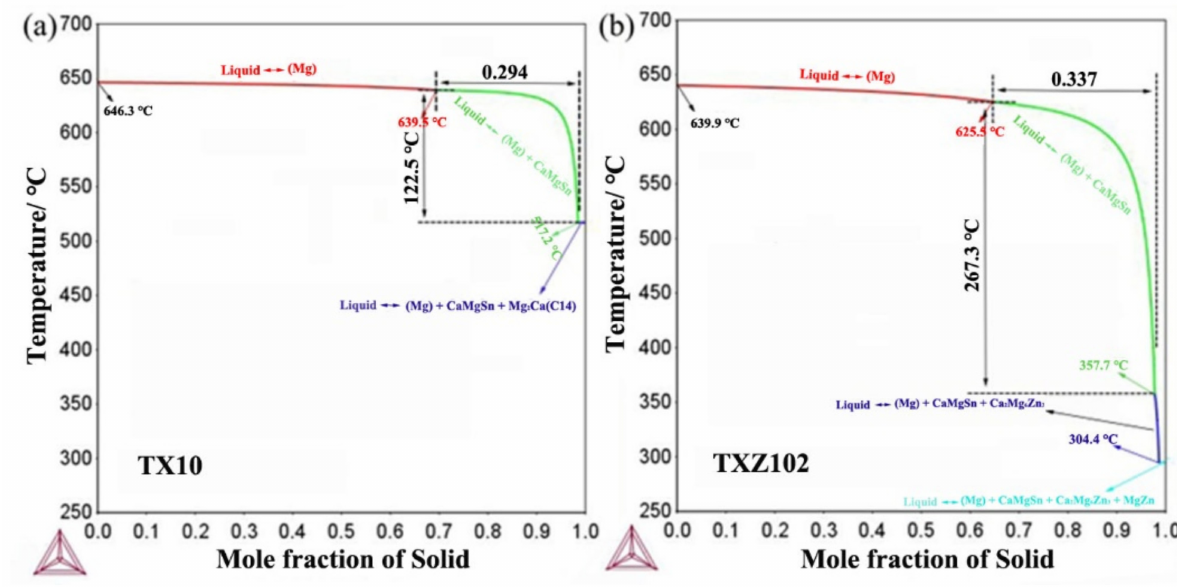
Figure 6. Simulated solidification path of Mg-1.0Sn-0.5Ca-based alloys with and without 2.0 wt.% Zn under Scheil–Gulliver conditions: ( a ) TX10 alloy; ( b ) TXZ102 alloy.